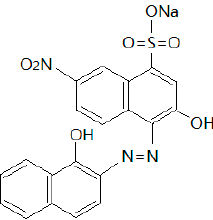
Figure 1. The chemical structure of Eriochrome Black T (EBT).